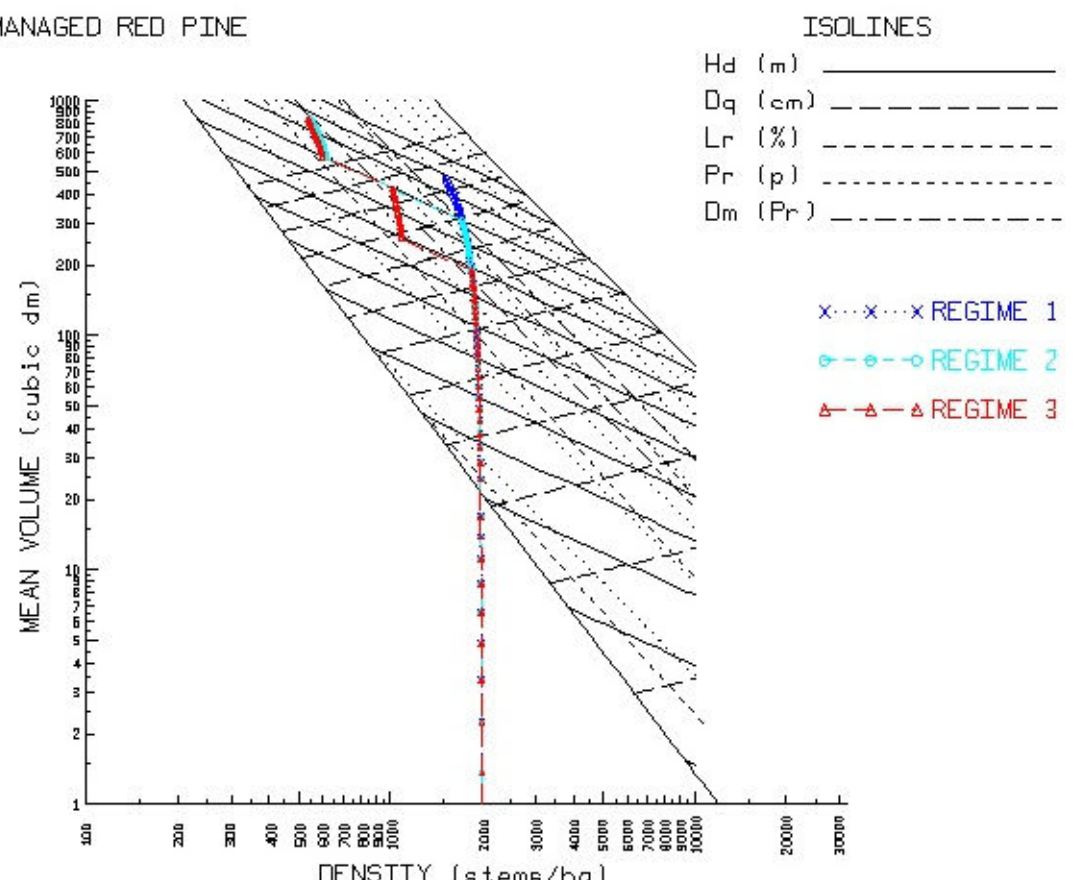
Figure 2. Temporal size–density trajectories for the 3 red pine plantations growing under conditions consistent a RCP8.5 climate change scenario on a medium-to-good site quality ( S I = 23) situated in north-central Ontario (Thessalon) as illustrated within the context of the SDMD graphic. Specifically, graphically illustrating: (1) isolines for mean dominant height (Hd; 4–30 m by 2 m intervals), quadratic mean diameter (Dq; 4–26 cm by 2 cm intervals), mean live crown ratio (Lr; 35, 40, 50, . . . , 80%), relative density index (Pr; 0.1–1.0 by 0.1 intervals); (2) crown closure line (lower diagonal solid line) and self-thinning rule at a Pr = 1.0 (upper diagonal solid line); (3) lower and upper Pr values delineating the optimal density management window (Dm; 0.35 ≤ Pr ≤ 0.50); and (4) expected 75 year (2022–2097) size–density trajectories with 1 year intervals denoted for each of the specified crop plans. Specifically, Regime 1 representing an initial spacing (2.2 × 2.2 m)—no-thinning crop plan; Regime 2 representing an initial spacing (2.2 × 2.2 m) with 1 commercial thinning (CT) treatment (35% basal area removed at 55 yrs) crop plan, Regime 3 representing an initial spacing (2.2 × 2.2 m) with 2 CT treatments (20% basal area removed at 40 yrs and 55 yrs) crop plan (refer to Table 1 and text for additional crop plan